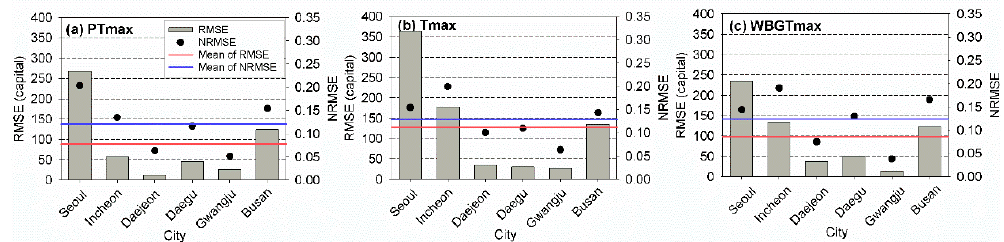
Figure 6. Root-mean-square error (RMSE) and normalized RMSE of the observed and estimated annual total mortalities for ( a ) PTmax, ( b ) Tmax, and ( c ) WBGTmax for the six cities during the test period (2017–2018).